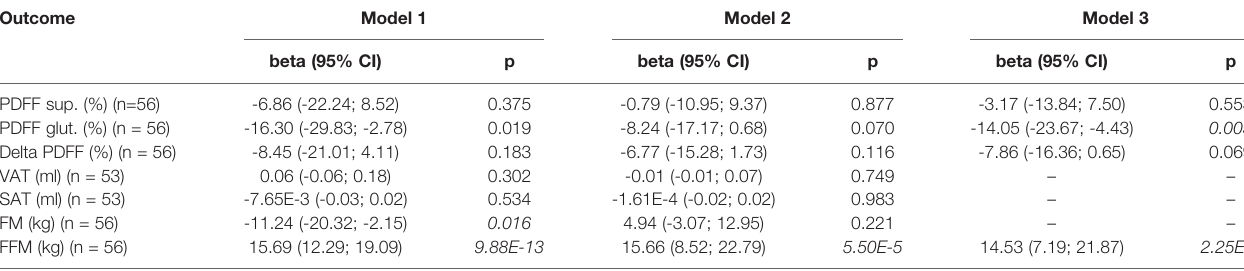
TABLE 3 | Association between parameters of adipose tissue and RMR in persons with BMI 19.5 – 24.9 kg/m 2